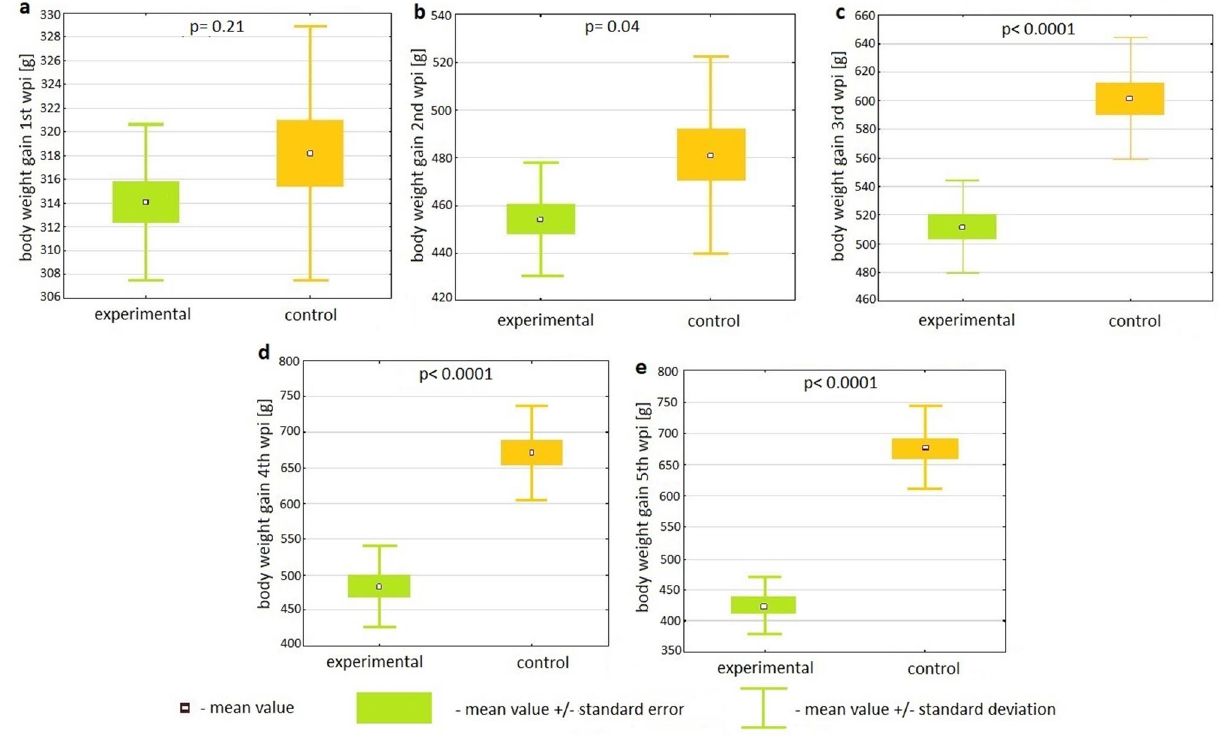
Figure 1. Box plots depicting the differences in weekly body weight gain between the control and experimental groups in the first ( a ), second ( b ), third ( c ), fourth ( d ) and fifth ( e ) weeks post inoculation with C. gallinacea. The difference between groups is statistically significant if p < 0.05; wpi week post